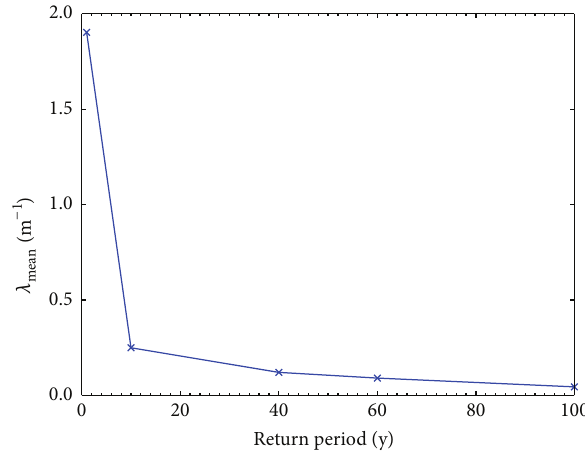
Figure 14: Mean value of lambda as a function of return period.